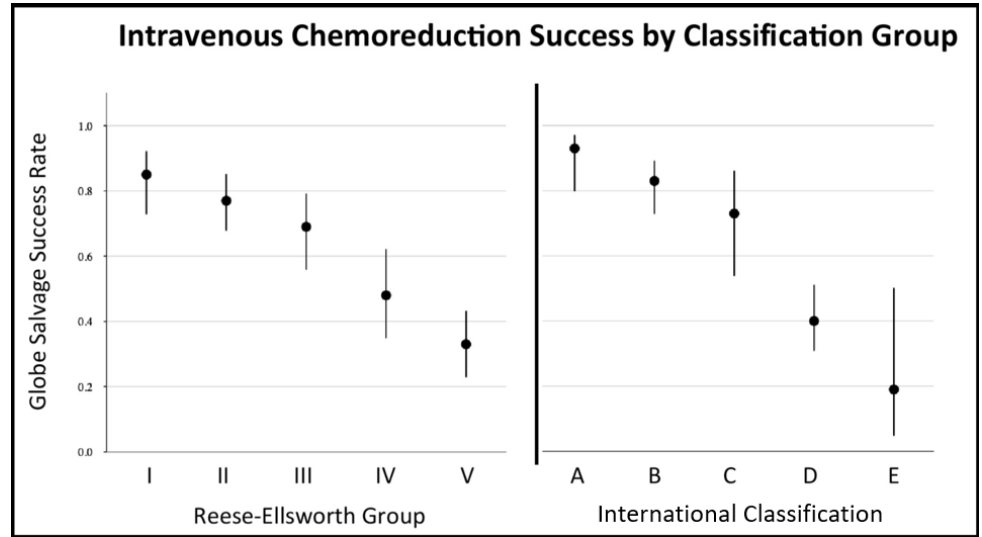
Figure 2. Globe salvage success rates by Reese – Ellsworth (left) and International Classification of Retinoblastoma/International Intraocular Retinoblastoma Classification (right), showing weighted point estimates with 95% confidence intervals. This trend was highly significant for both Reese – Ellsworth classification ( p < 0.001) and ICRB/IIRC ( p = 0.001).